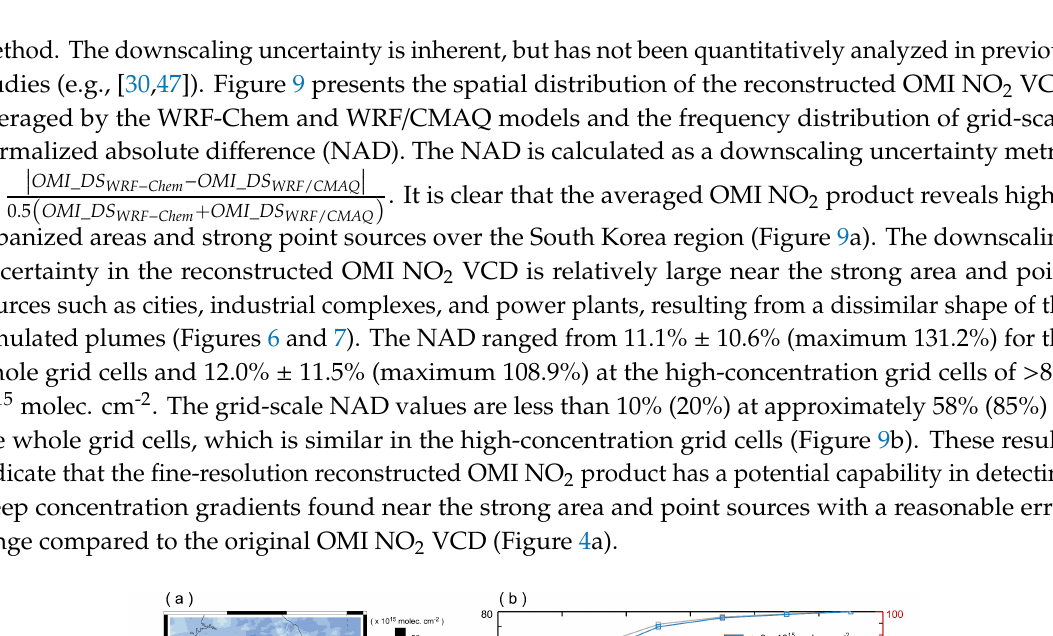
Figure 8. A comparison of (a) the modeled NO 2 VCD and (b) the reconstructed OMI NO 2 VCD by the WRF-Chem and WRF/CMAQ models over the South Korean region. The modeled NO 2 VCD in ( a ) were calculated by applying the KNMI OMI averaging kernels to the modeled vertical profiles of NO 2 concentrations.